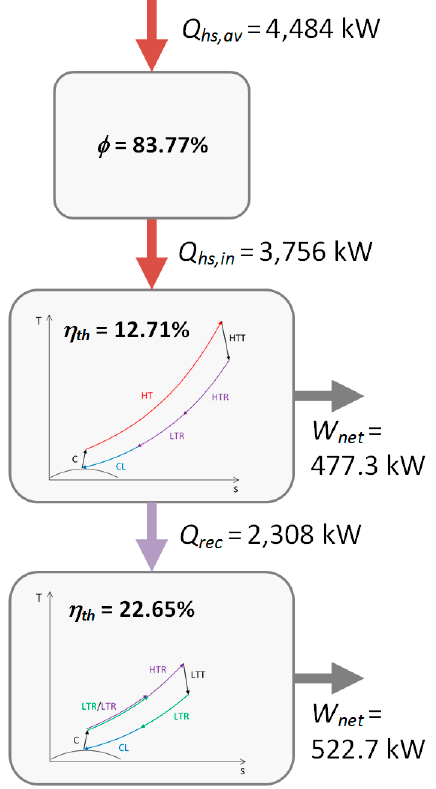
Figure 9. Single flow split with a dual expansion cycle. Breakdown of the overall performance into a chain of efficiencies, which include the thermal efficiencies of the elementary cycles.